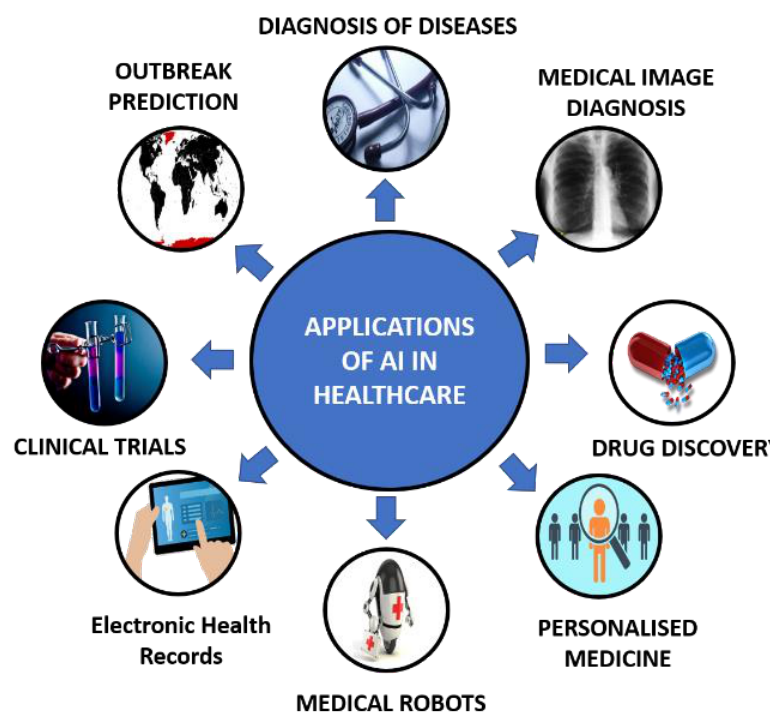
Figure 3. A representation of various applications of AI in healthcare.